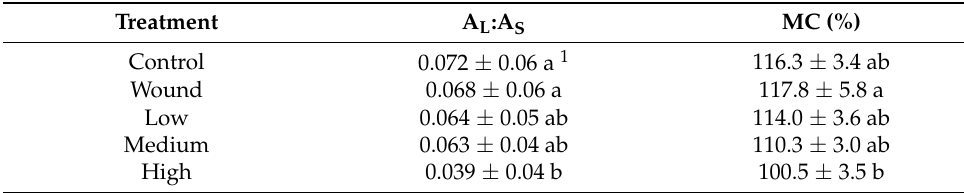
Figure 3. Mean projected tree leaf area of P. taeda in the third year after lower stem inoculation with L. terebrantis- colonized or sterile toothpicks or no inoculation. Means associated with different lowercase letters are significantly different at an α -level of 0.05 by the Tukey HSD test for multiple comparisons. Bars represent one standard error of the mean. Table 3. Means and standard errors of the ratio of tree projected leaf area and sapwood area (A L :A S ) and foliage moisture content expressed on dry weight basis (MC) 34 months following stem inoculation of P. taeda trees with L. terebrantis near Eufaula, AL,